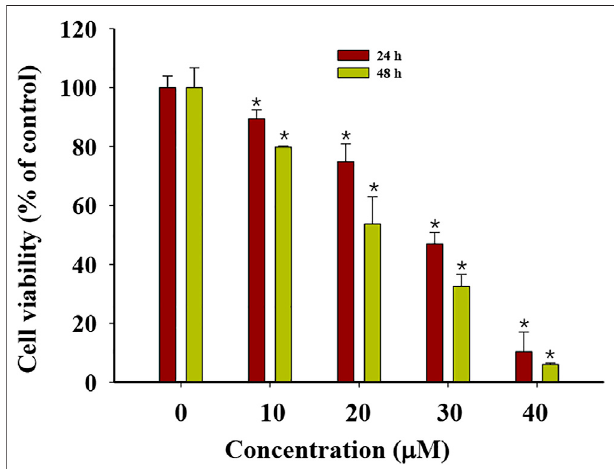
FIGURE 7 | Cytotoxicity of G-Rh2 to A549 cells. Cells were treated with G-Rh2 for 24 and 48 h and viability was evaluated by MTT assay. Values are means ± SD ( n = 3).